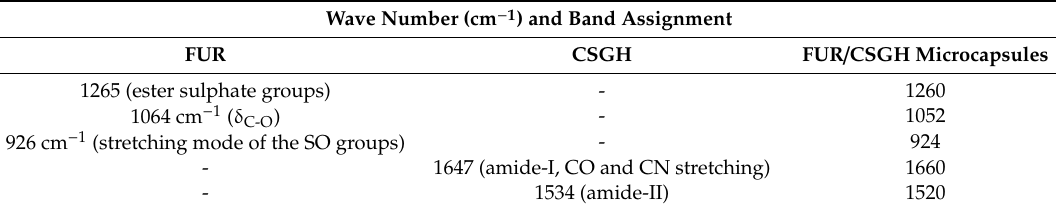
Table 2. Characteristic bands of the FT-IR spectra of microcapsules and their components.